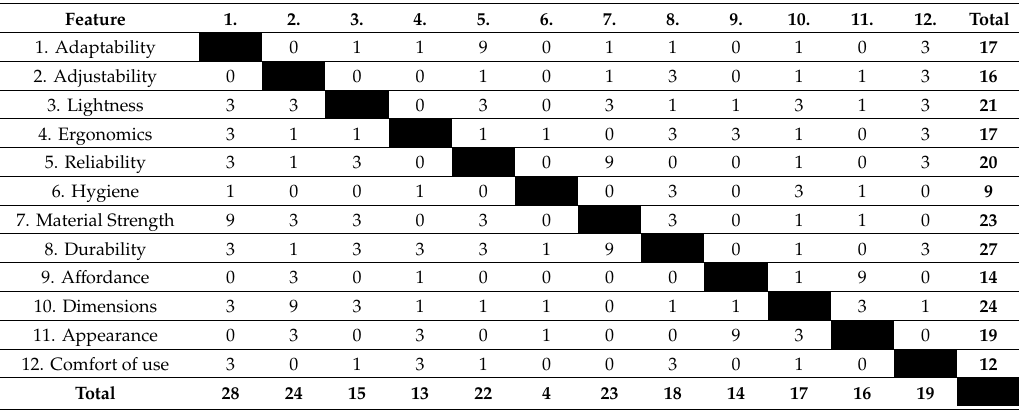
Table 2. Relationship Matrix: Dependence /